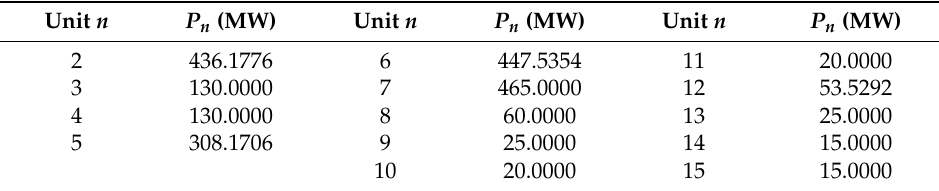
Table A3. The best decision variables for system 3 found by the proposed method.